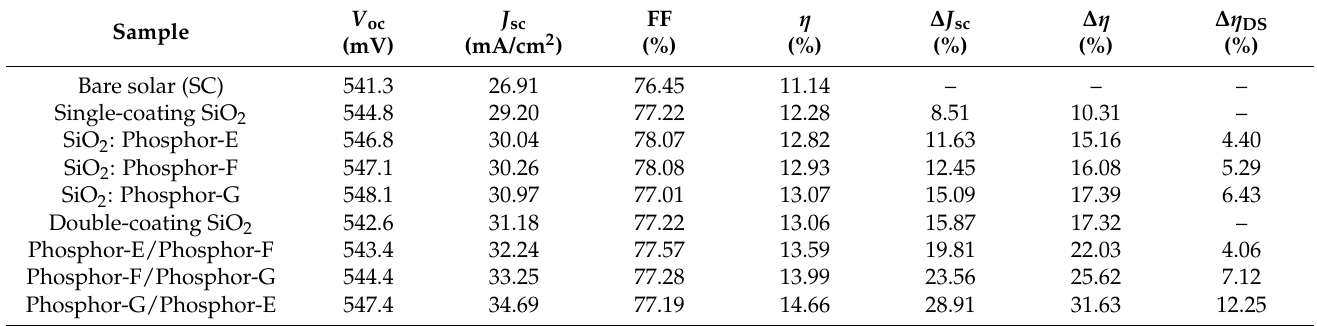
Table 2. Photovoltaic performance of bare cell, cell with SiO 2 layer, and cells with